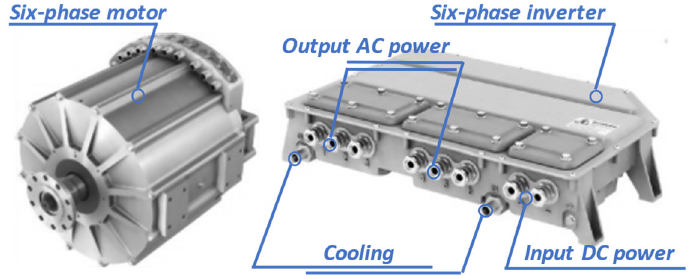
Figure 31. Multiphase drive for an electric bus by Tron-e [162].